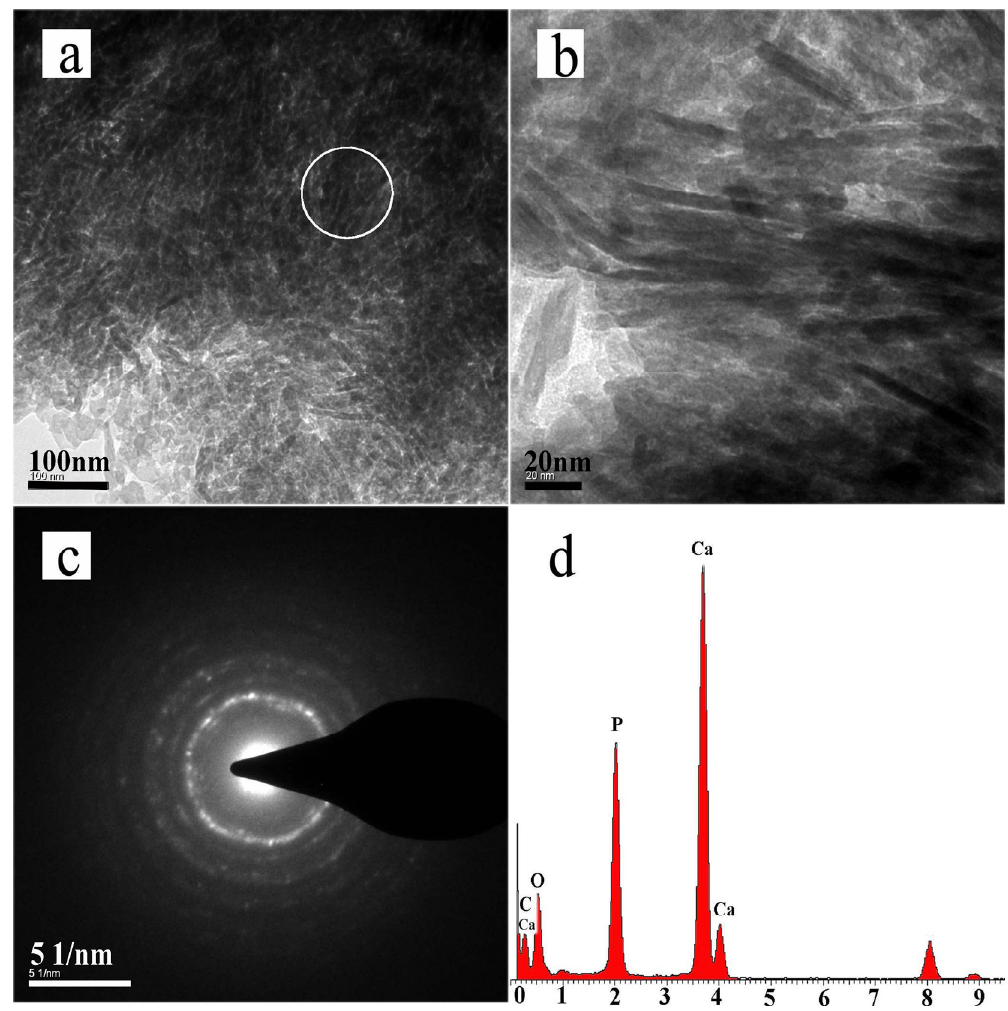
Figure 5. TEM micrographs of dentin remineralized after six remineralization cycles. ( a ) Transmission electron microscopy (TEM) bright ‐ field micrographs of unstained remineralized dentin collagen fibrils after six remineralization cycles; ( b ) Magnified view of panel a; ( c ) Selected area electron diffraction (SAED) pattern of remineralized dentin collagen fibrils; ( d ) EDX spectra of the remineralized fibrils.